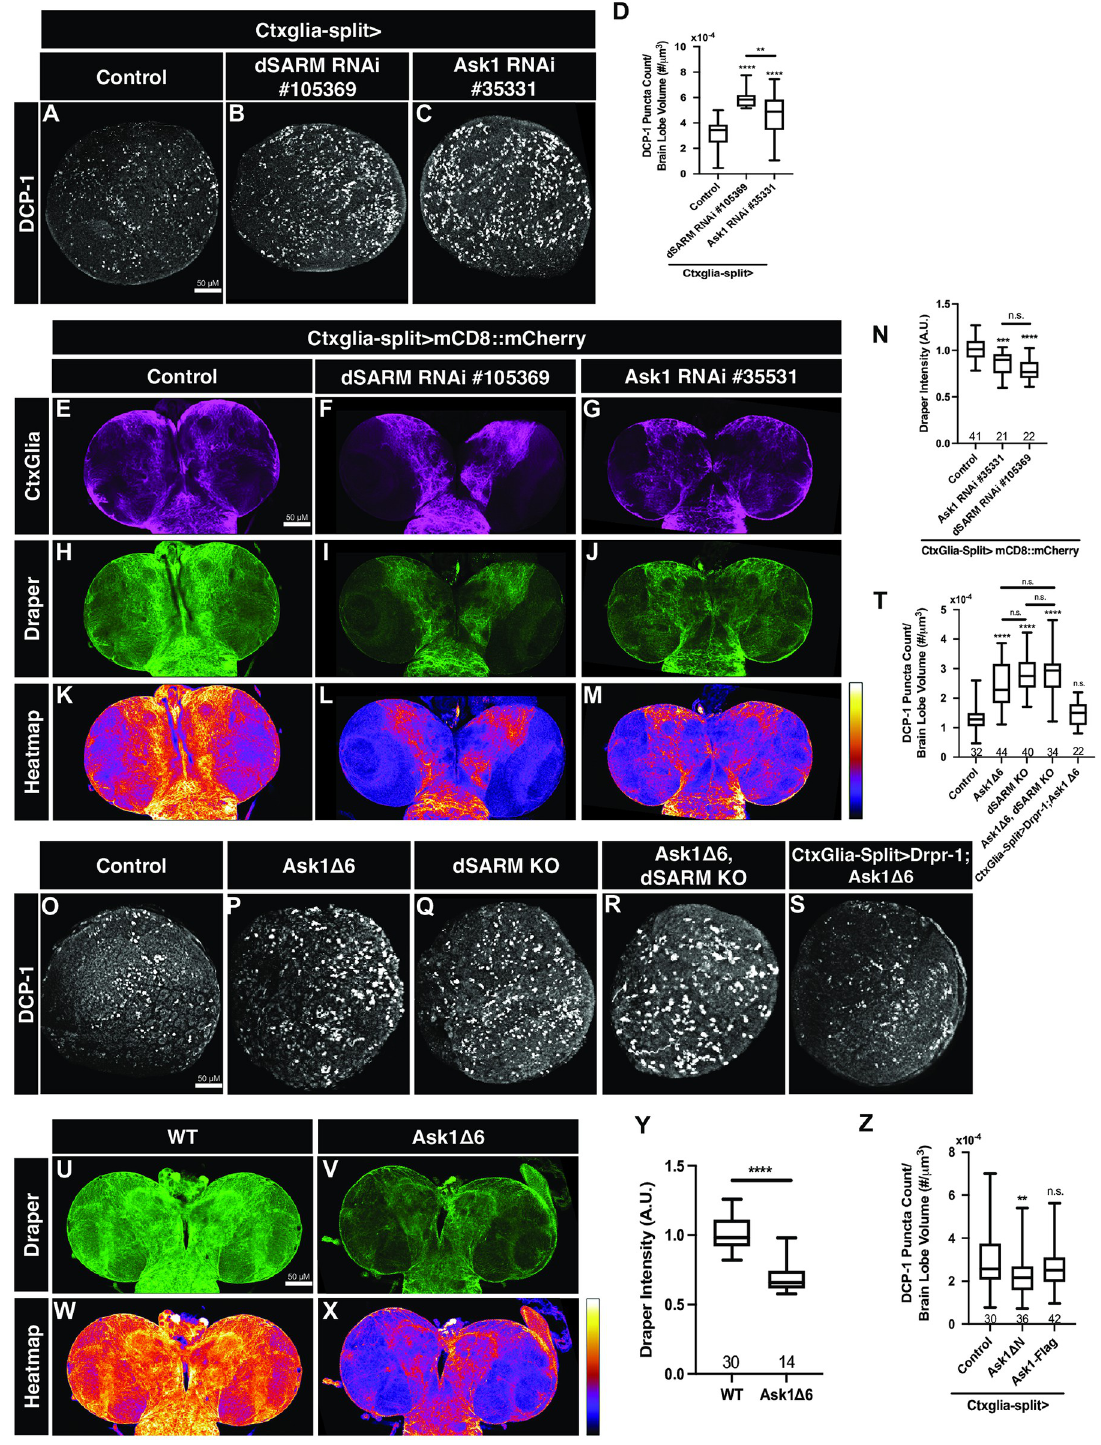
Fig 7. dSARM and Ask1 are in a linear genetic pathway in cortex glia. (A-C) Representative z-projections of brain lobes of the indicated genotypes labeled with anti-Dcp-1. (D) Quantification of the mean number of Dcp-1 puncta per brain lobe normalized to brain lobe volume: Control (Ctxglia-split > OR) (n = 44): 3.05x10 -4 , Ctxglia-split > dSARM RNAi #105369 (n = 18): 5.98x10 -4 , and Ctxglia- split > Ask1 RNAi #35331 (n = 42): 4.62x10 -4 . (E-G) Representative 3 mm z-projections of larval brains of indicated genotypes labeled with anti-mCherry. (H-J) Representative 3 mm z-projections of larval brains of indicated genotypes labeled with anti-Drpr. (K-M)